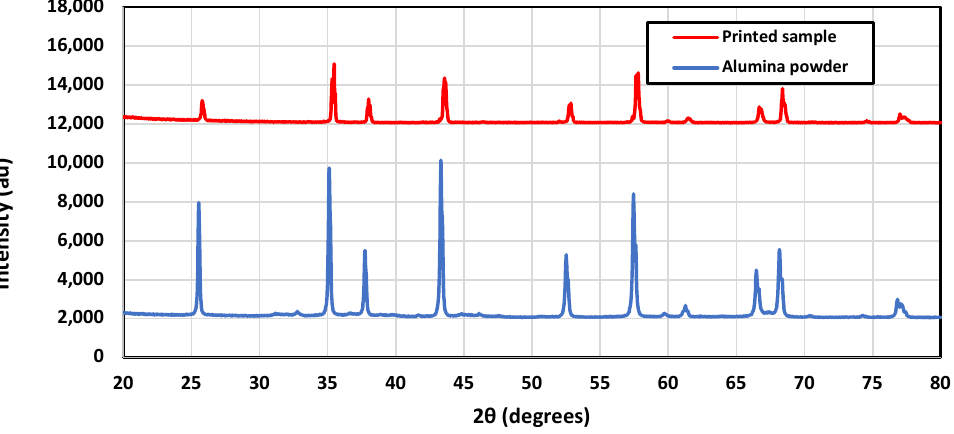
Figure 16. XRD spectra for the starting alumina feedstock and the printed sample (A).